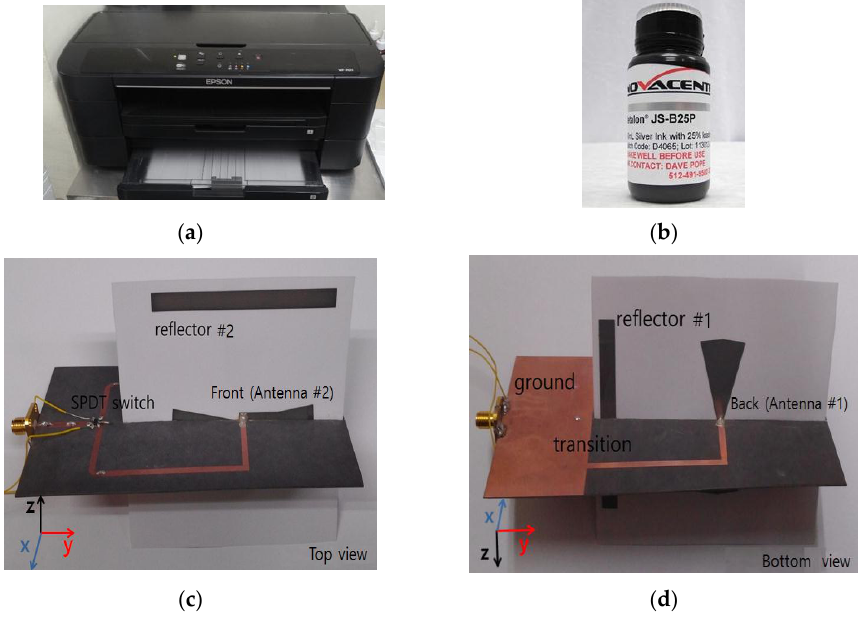
Figure 6. Pictures of home inkjet printer, silver nanoparticle ink and fabricated antenna system; ( a ) home printer (WF-7011); ( b ) silver ink (JS-B25); ( c ) prototype antenna top view; and ( d ) prototype antenna bottom view.